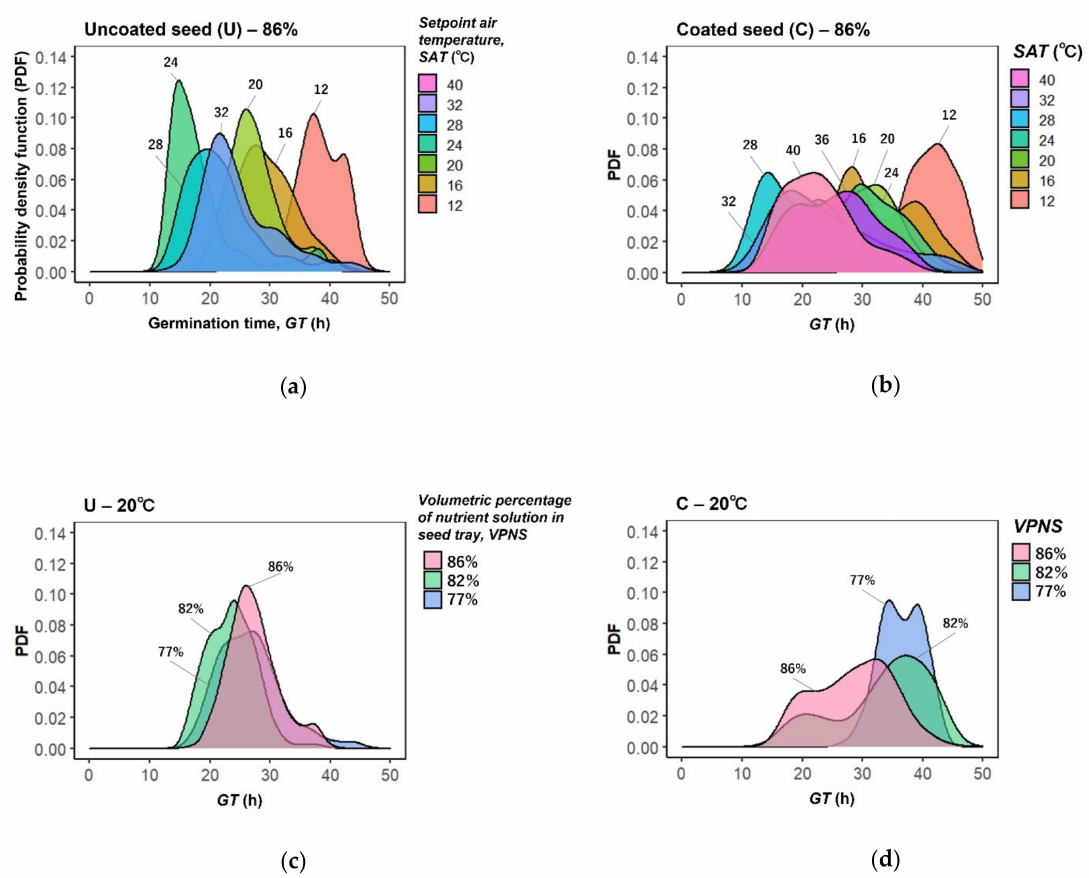
Figure 5. Probability density function (PDF) of germination time ( GT ) under (1) di ff erent setpoint air temperature ( SAT ) and volumetric percentage of nutrient solution in seed tray ( VPNS ) of 86% each with ( a ) uncoated seed—U and ( b ) coated seed—C, and (2) di ff erent VPNS and SAT of 20 ◦ C with U ( c ) and C ( d ) (see Table 1 for